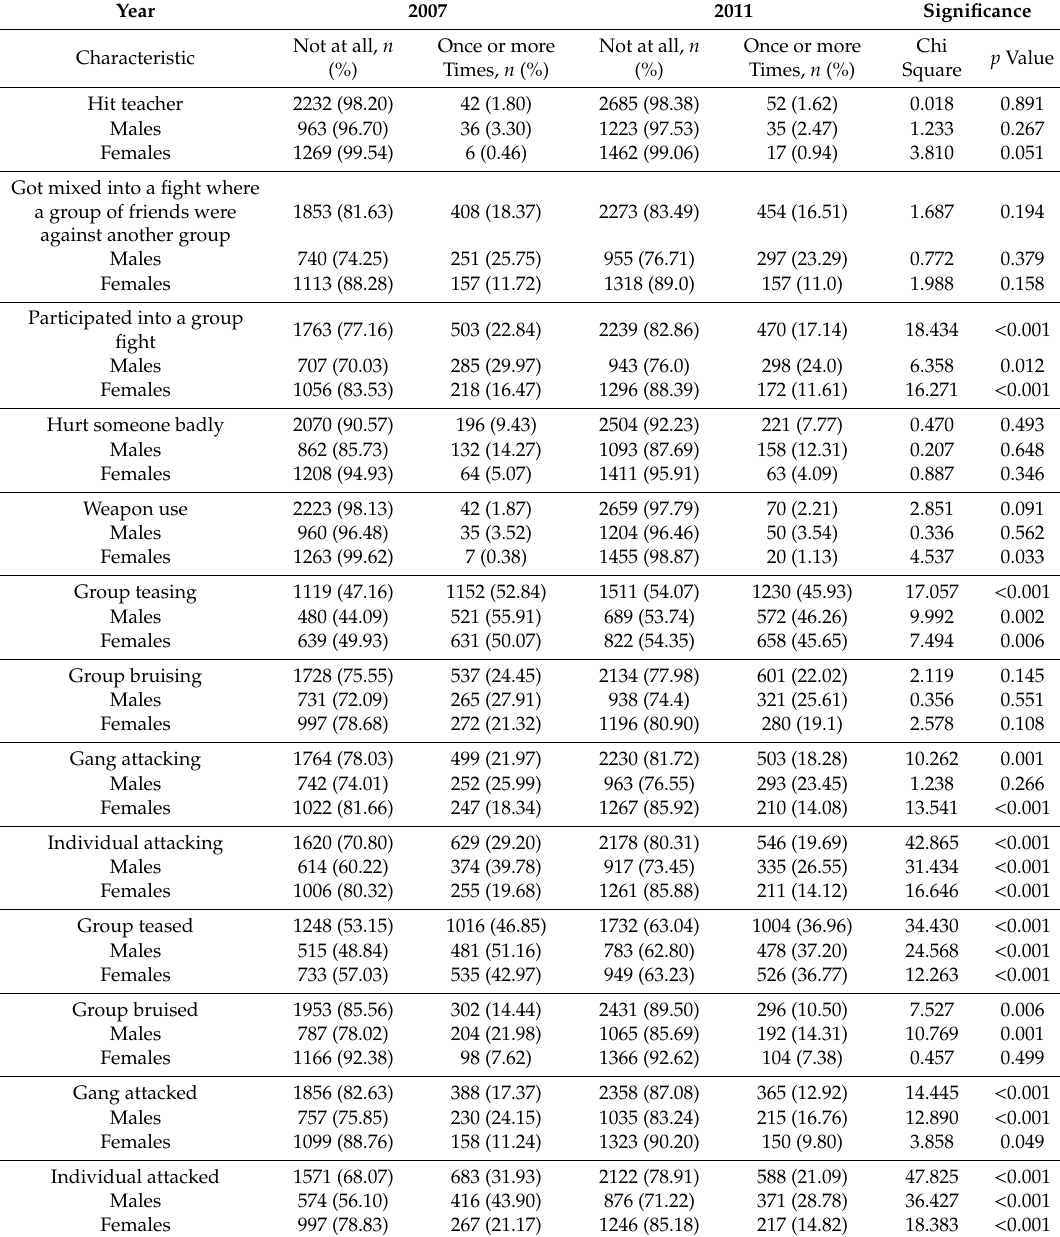
Table 3. Violent behavior: 2007 compared to 2011 among Romanian